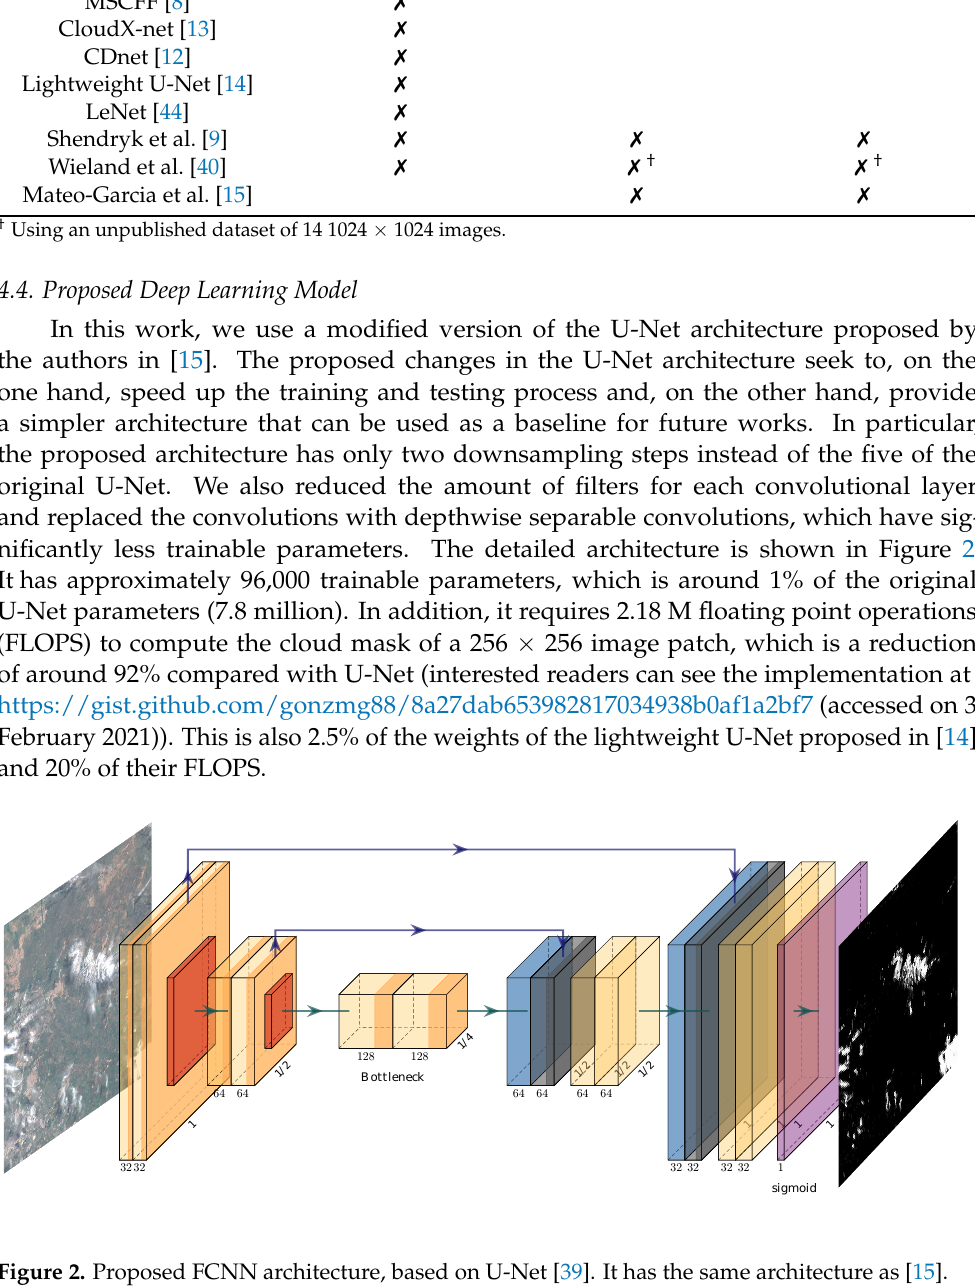
Figure 2. Proposed FCNN architecture, based on U-Net [39]. It has the same architecture as [15]. Networks were trained and tested using top of atmosphere (TOA) calibrated radiance as the input. In particular, we used Level 1TP Landsat-8 products and Level 1C Sentinel-2 products, respectively, converted to TOA reflectance using their corresponding calibra- tion factors available in the metadata of the image. These TOA reflectance inputs